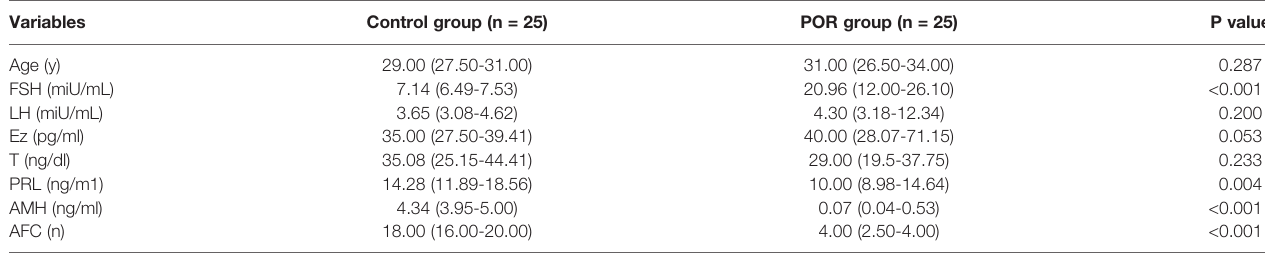
FSH, follicle stimulating hormone; LH, luteinizing hormone; E2, estradiol; T, testosterone; PRL,prolactin; AMH, antimmüllerian hormone; AFC, antral follicle